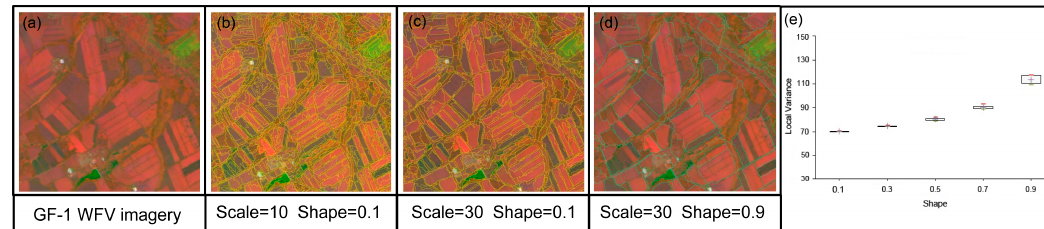
Figure 5. Image segmentation at two scale levels and with two shape parameters: ( a ) Standard false color composites (band rank: near-infrared, red, and green) of GF-1 WFV layer stack imagery; ( b ) Segmentation at scale value of 10 and shape parameter value of 0.1; ( c ) Segmentation at scale value of 30 and shape parameter value of 0.1; ( d ) Segmentation at scale value of 30 and shape parameter value of 0.9; ( e ) Box plot depicting local variance (LV) against the different shape parameter settings at a scale value of 30 of the multiresolution segmentation algorithm.